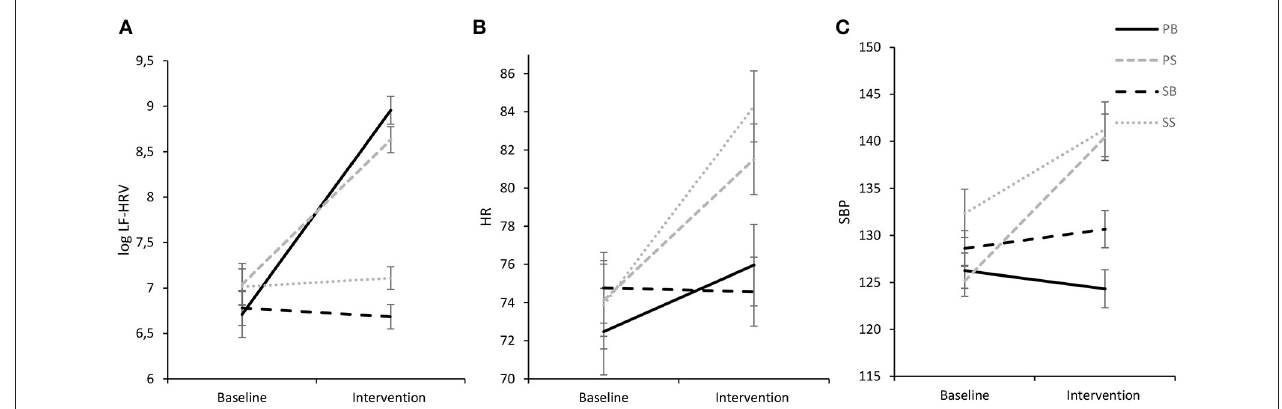
FIGURE 3 | Experimental intervention effects for log LF-HRV (A) , HR (B) , and SBP (C) (M ± 1 SE). log LF-HRV, low-frequency HRV; HR, heart rate; SBP, systolic blood pressure; ln, natural logarithmic transformation. PB, paced breathing at 0.1Hz; PS, paced singing at 0.1Hz; SB, spontaneous breathing; SS, spontaneous singing. This figure show elevated LF-HRV for both paced interventions and increases in cardiovascular activity for both singing